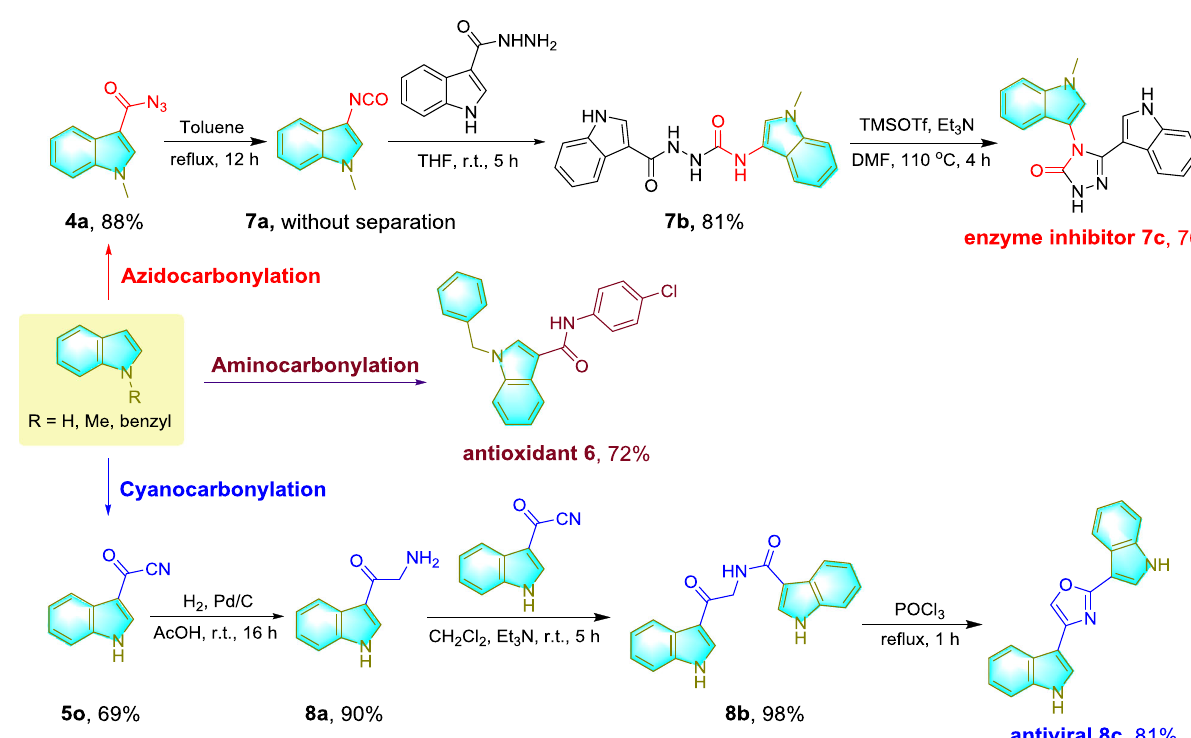
Fig. 6 Synthetic applications. The synthesis of representative bioactive molecules via KAP-Pd-PEPPSI catalyzed carbonylations of